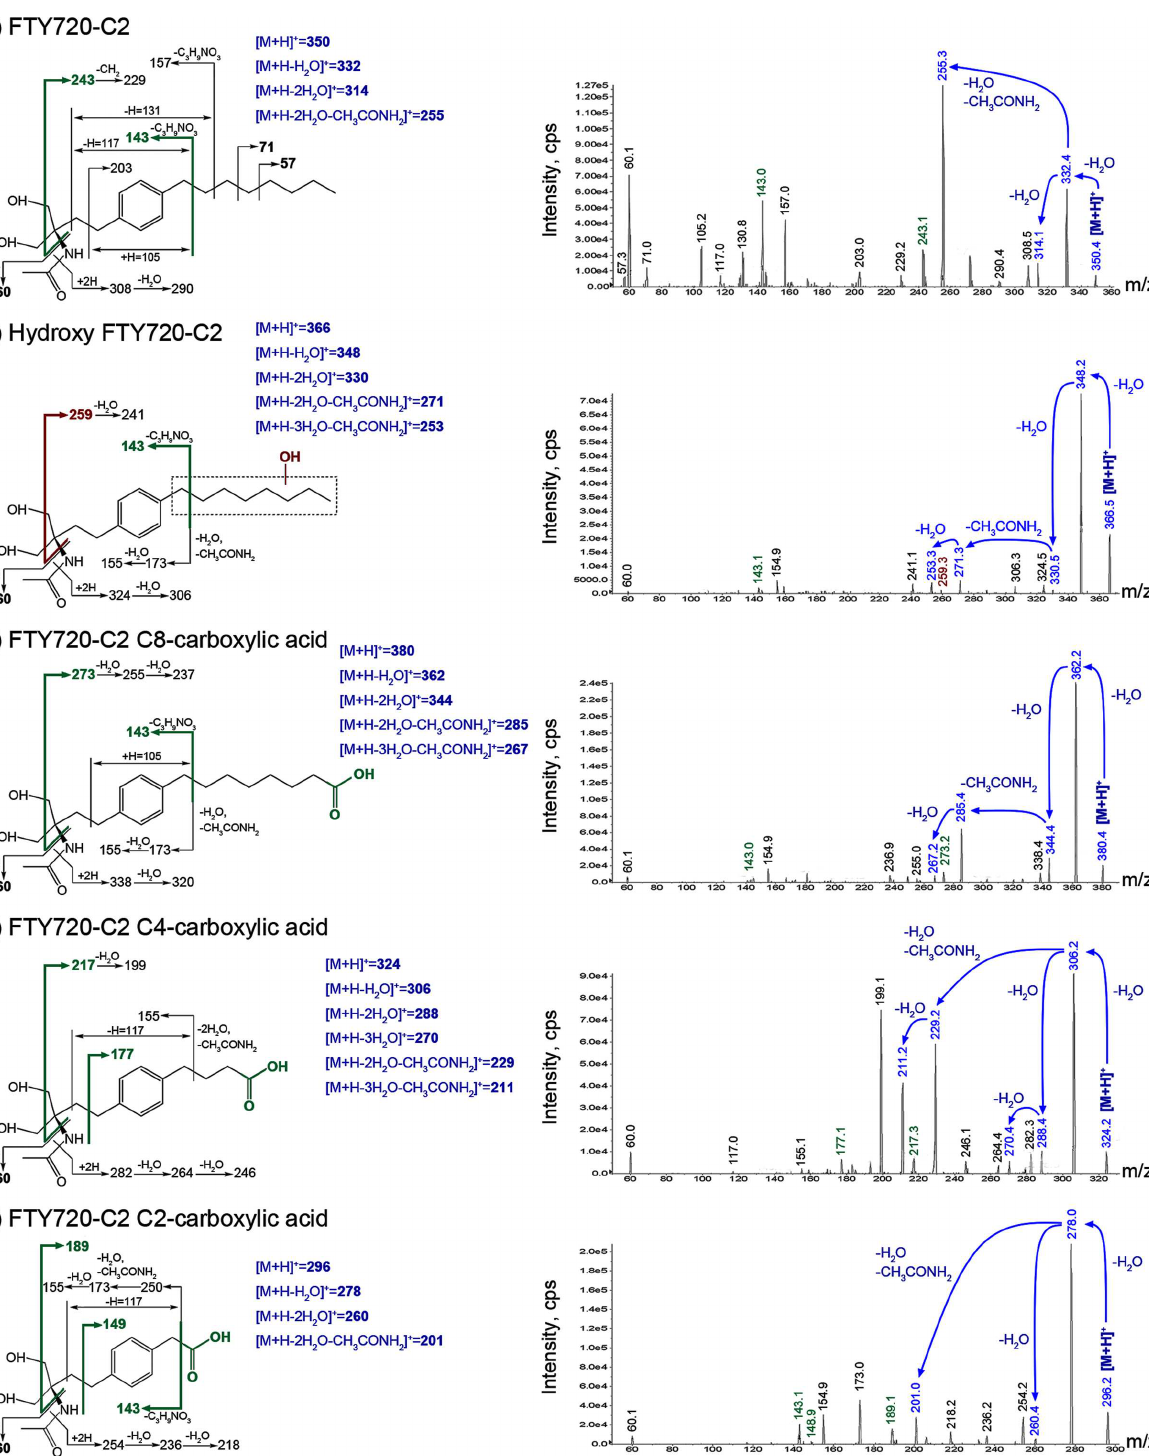
PLOS ONE | DOI:10.1371/journal.pone.0162162 September9,